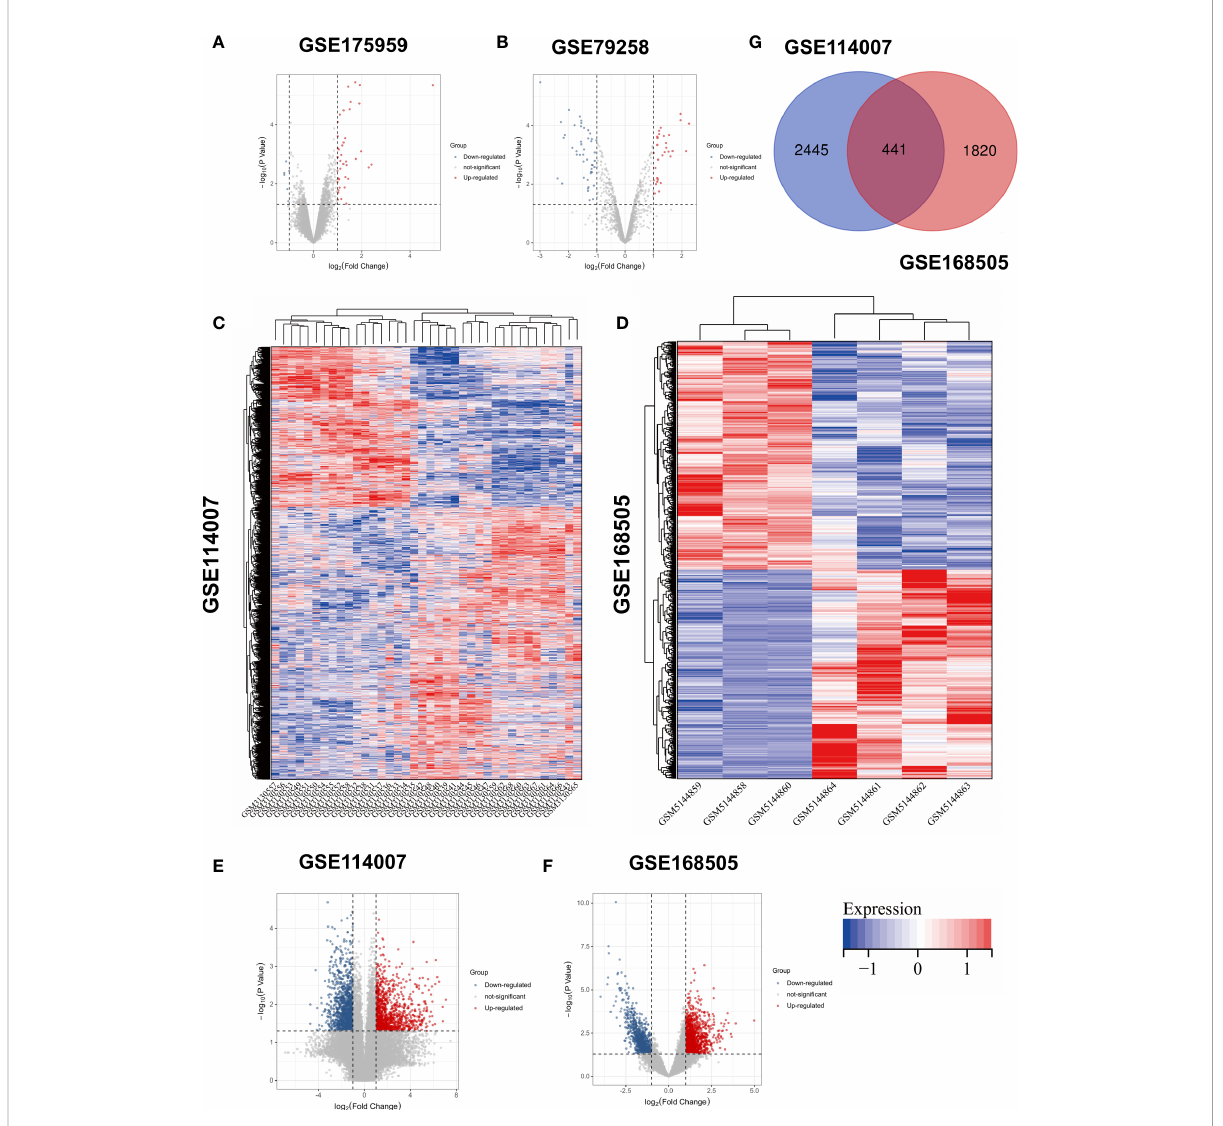
FIGURE 1 Volcano plots of (A) GSE175959; (B) GSE 79258; Heatmaps of (C) GSE114007; (D) GSE168505; Volcano plots of (E) GSE114007; (F) GSE168505. (G) Venn diagram of screening DEGs form mRNA expression pro fi